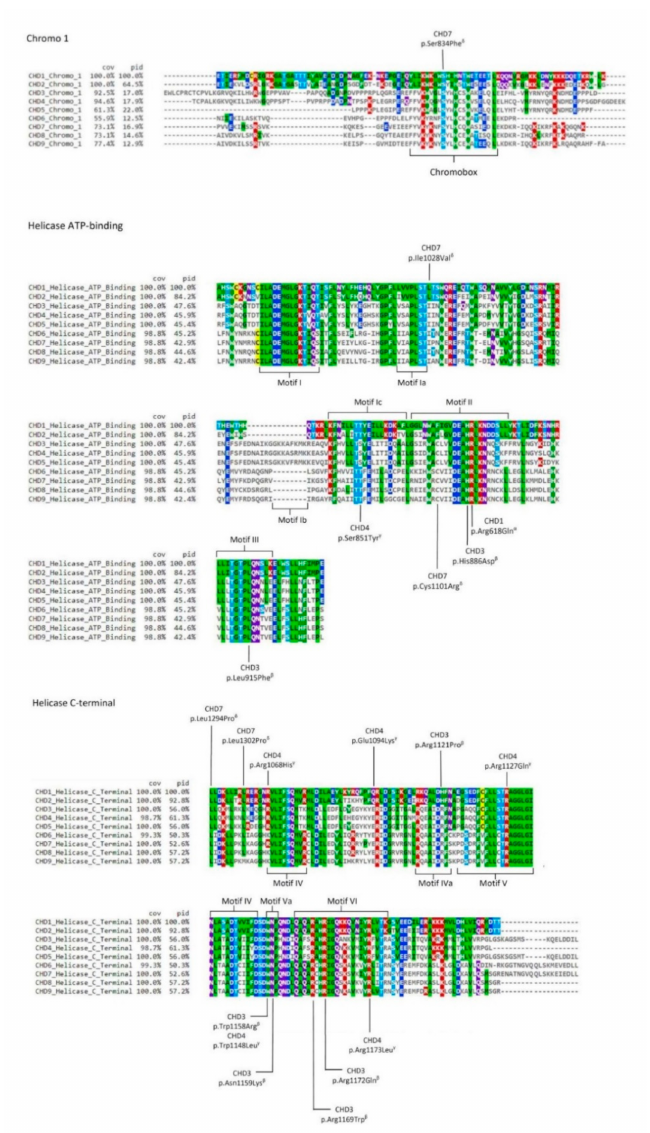
Figure 3. Scheme of CHD paralogues with pathogenic variants obtained from the ClinVar database (https://www.ncbi.nlm.nih.gov/clinvar. Accessed on 2 November 2020) [63] also described in the literature (Table 1) for domains Chromo 1, Helicase ATP-binding, and Helicase C-terminal. Letters α , β , γ , and δ represent the clinical phenotypes associated with each pathogenic variant (see Table 1). Chromobox and motifs I, Ia, Ib, Ic, II, III, IV, IVa, V, Va, and VI are displayed. The colour scheme represents the variable amino acid positions after using the multiple alignment viewer MView (COV—% coverage; ID—% identity). The mapping of the chromobox and the motifs was performed according to references